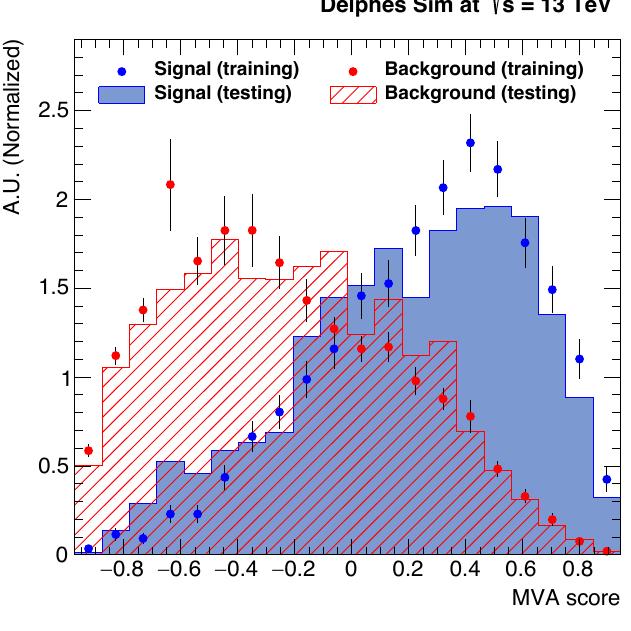
Figure 5 . Normalized BDT output distribution for signal and background events. The signal events tend to be close to 1 and the background events are close to samples are indicated by the dot and the (cid:12)lled histograms, respectively. The training and testing samples are compatible with each other which means there is no over(cid:12)tting. We have utilized Delphes [145, 146] to simulate the detector